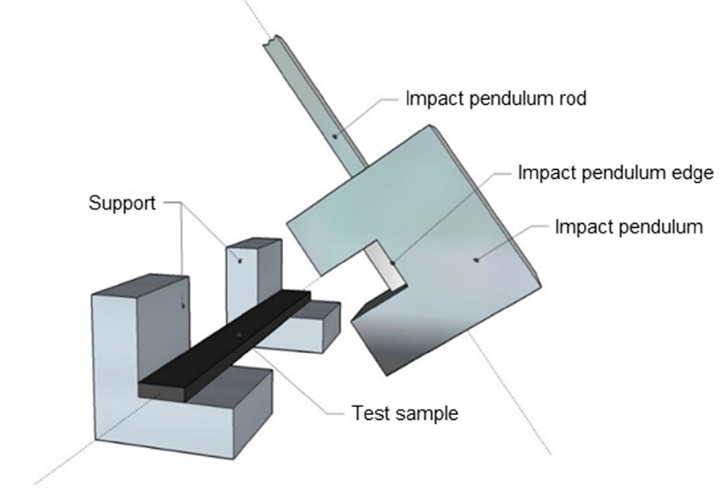
Figure 3. Schematic of the Charpy impact test.